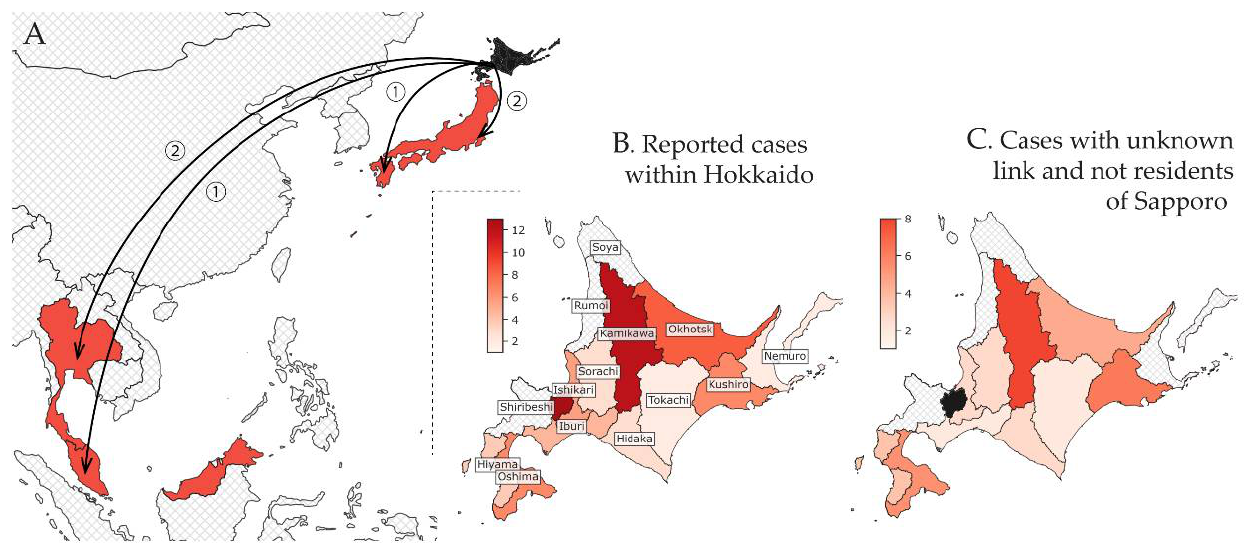
Figure 1. Geographical distribution of confirmed cases linked to Hokkaido by subprefecture of diagnosis as of 29 February 2020. ( A ) International and domestic cases (excluding Hokkaido). Hokkaido is shaded in black, whereas affected countries are depicted in red. The circled numbers indicate the total count of cases for each import destination. ( B ) All cases confirmed in Hokkaido. The labels indicate the names of the subprefectures of Hokkaido. ( C ) Only cases included in our analysis: non-residents of Sapporo with unknown links either with or without history of travel to Sapporo. Ishikari subprefecture was separated into two subregions: Sapporo city and outside Sapporo city. Hatched areas in grey indicate subprefectures with zero counts. Table 1. Exportation events and estimated incidence in Hokkaido by date of report.